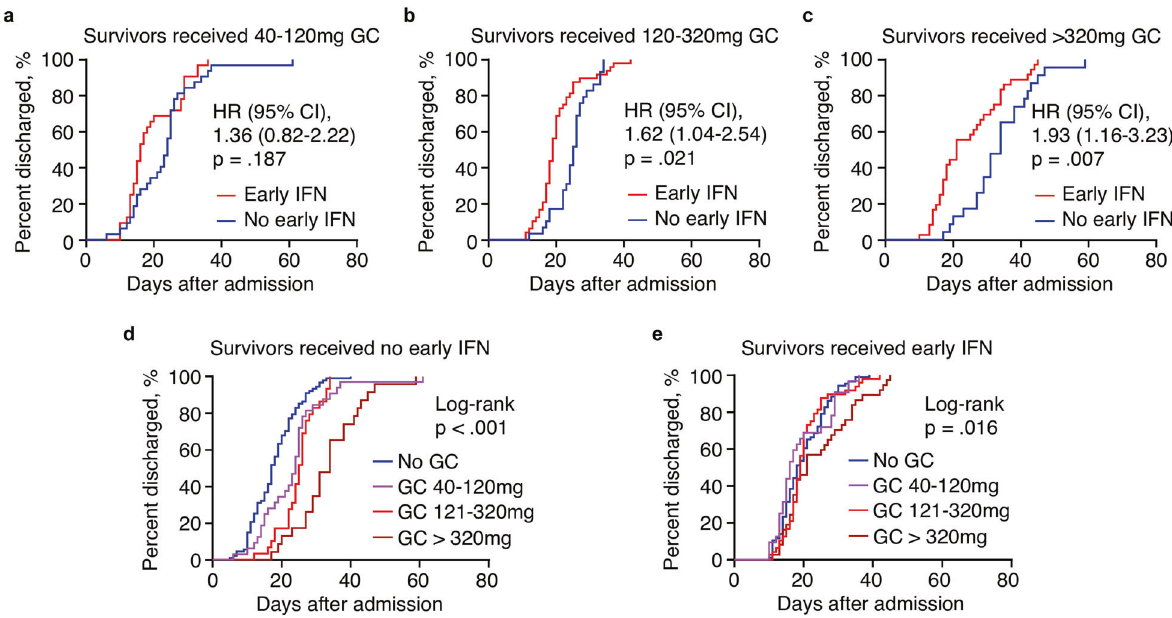
Fig. 4 Association of early IFN therapy with early recovery from COVID-19 depended on GC cumulative dose. a – c Cumulative incidence curves for hospital discharge among survivors receiving 40 – 120 mg ( a ), 120 – 320 mg ( b ), or >320 mg methylprednisolone-equivalent doses of GC in total during hospitalization. n = 32 for a , 48 (early IFN) and 29 (no early IFN) for b , 36 (early IFN) and 23 (no early IFN) for c . e , f Cumulative incidence curves for hospital discharge among survivors without ( e ) or with early IFN therapy ( f ). P -values were calculated by comparing all 4 curves. n = 87 (no GC), 32 (GC 40 – 120 mg), 29 (GC 121 – 320 mg), and 23 (GC > 320 mg) for e , 87 (no GC), 32 (GC 40 – 120 mg), 48 (GC 121 – 320 mg), and 36 (GC > 320 mg) for